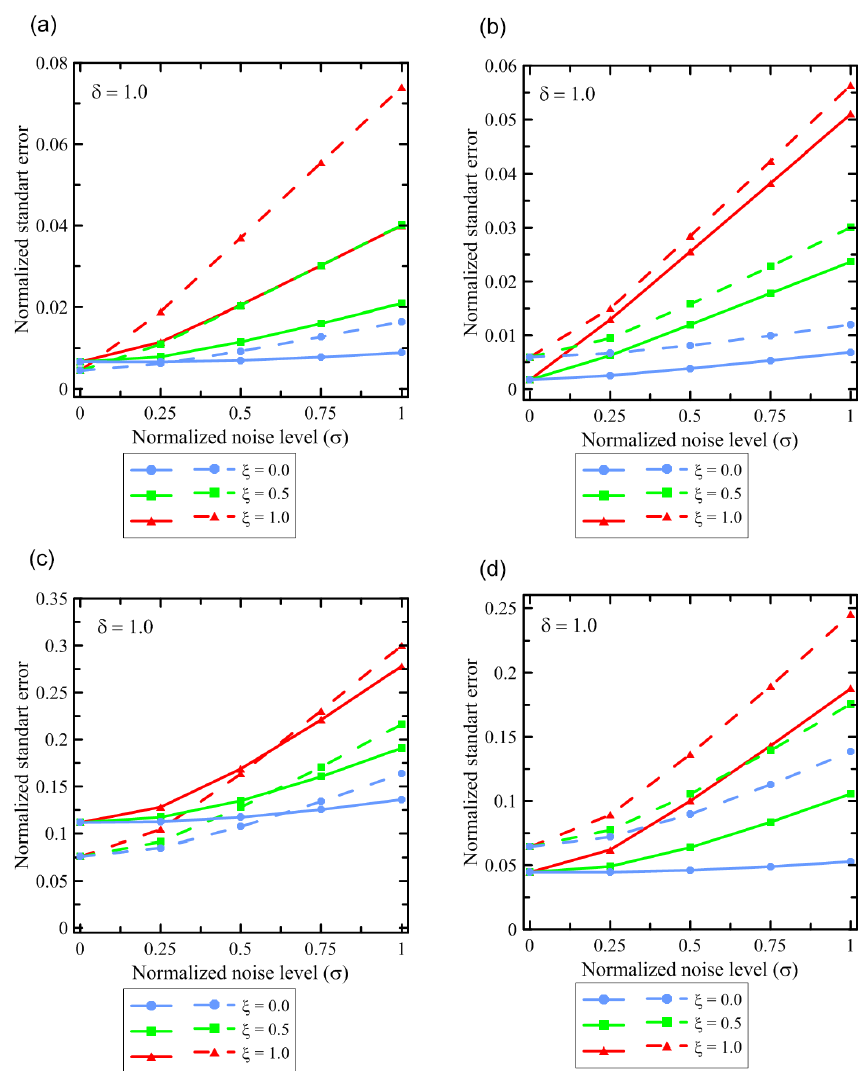
Figure 6. Results of the OSSEs for estimation of NO x (a, b) and CO (c, d) emissions: the dependencies of the normalized standard error of the NO x (CO) emission estimates for the EHI (a, c) and TCO (b, d) source categories on the level of noise (that is, on the value of the diagonal elements, σ , of the error covariance matrixes) in the input “synthetic” data. The noise level is normalized to its magnitude estimated with the real measurement and simulation data. Apart from the random noise, the synthetic data included the bias that was specified (for any given day) by linearly interpolating (in time) the monthly biases shown in Fig. 3c, d. Different colors show the results obtained with the different levels of error co-variances ( ξ is the scaling factor applied to non-diagonal elements of the covariance matrix). The standard errors estimated in the “direct” way (as the RMSE representing the differences between the emission estimates inferred from the synthetic data and the “true” NO x emission estimates) and by using the subsampling technique are shown by solid and dashed lines,